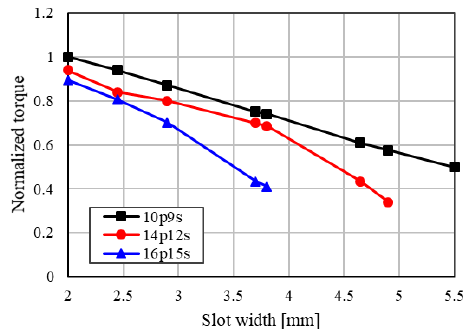
Figure 13. Generated torque due to the effect of the tooth cross-sectional area.